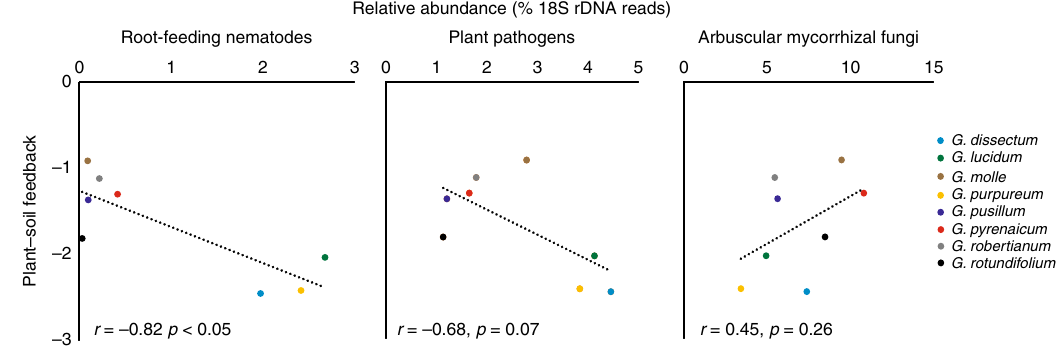
Fig. 4 Predictors of plant – soil feedback. Correlations between plant – soil feedback (ln(biomass conditioned /biomass control ); average of fi ve independent replicate soils) of eight Geranium species and the relative abundances (% 18S rRNA gene reads) of root-feeding nematodes, plant pathogens (see Methods), and arbuscular mycorrhizal fungi (AMF) in the conditioned soils. Statistical differences were examined using a Pearson ’ s correlation test. Pearson ’ s correlation coef fi cients r and p -values of Pearson ’ s correlation tests are shown. Source data are provided as a Source Data fi